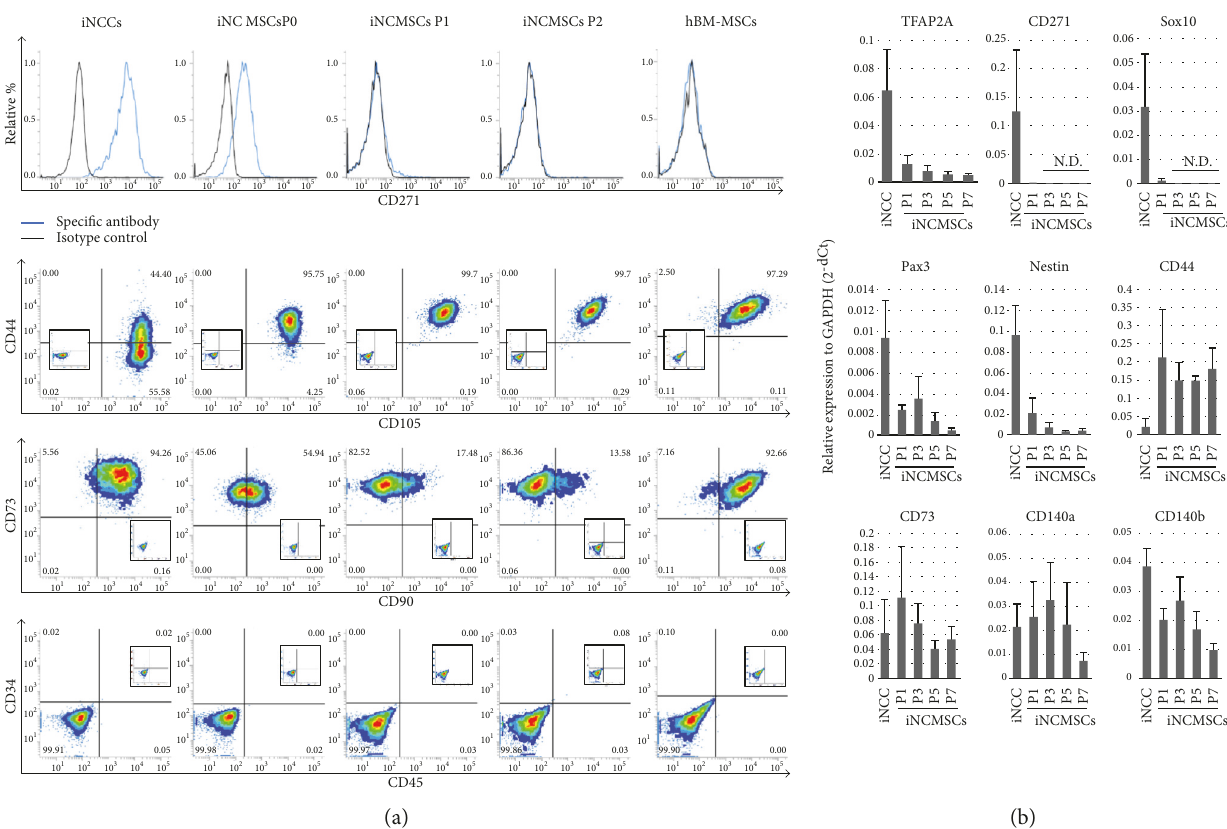
Figure 3: Neural crest markers and mesenchymal stem cell markers. (a) FACS analysis of NC and MSC surface markers in iNCC and iNCMSC (P0, P1, and P2). The date are representative of four lines. Human bone marrow derived MSCs were used for assay control. (b) Gene expression of NC and MSC markers during expansion of iNCMSCs (mean ± SD for four lines). Abbreviations: iNCCs: induced neural crest cells; iPSCs: induced pluripotent stem cells; iNCMSCs: induced neural crest derived mesenchymal stem cells; hBM-MSCs: human bone marrow-derived